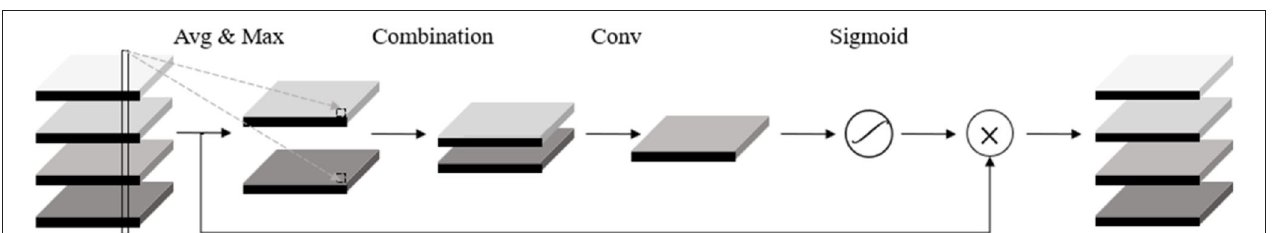
FIGURE 12 | Channel attention module.